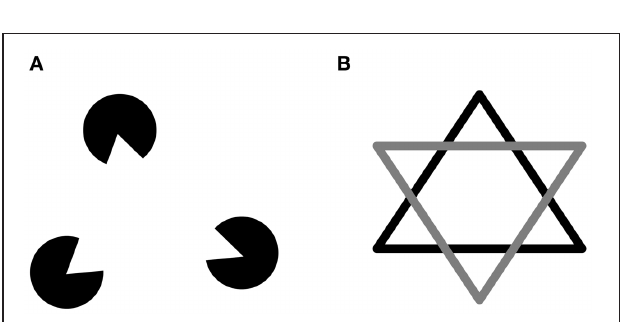
FIGURE 3 | (A) Kanizsa (illusory) triangle; (B) Star of